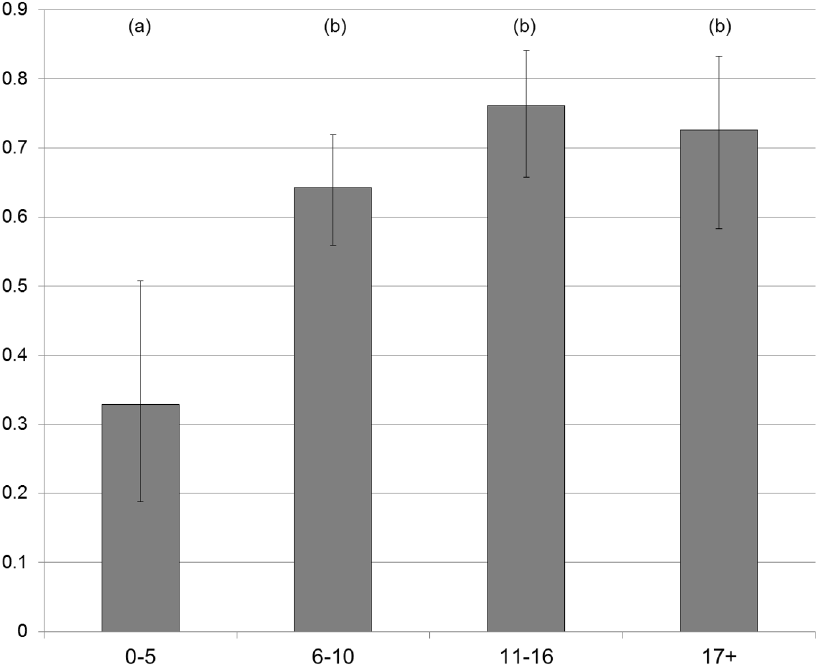
Figure 4. Effect of age on conformity. Estimated marginal means and 95% confidence intervals for the average proportion of text in the answers for the different age classes. (a) and (b) denote significant differences between classes.